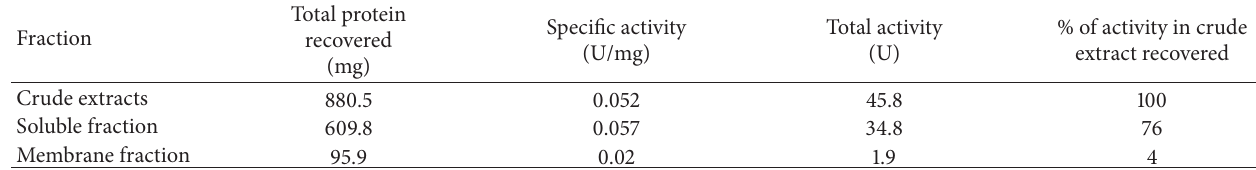
Table 1: Localization of Fe(III) reductase activity.